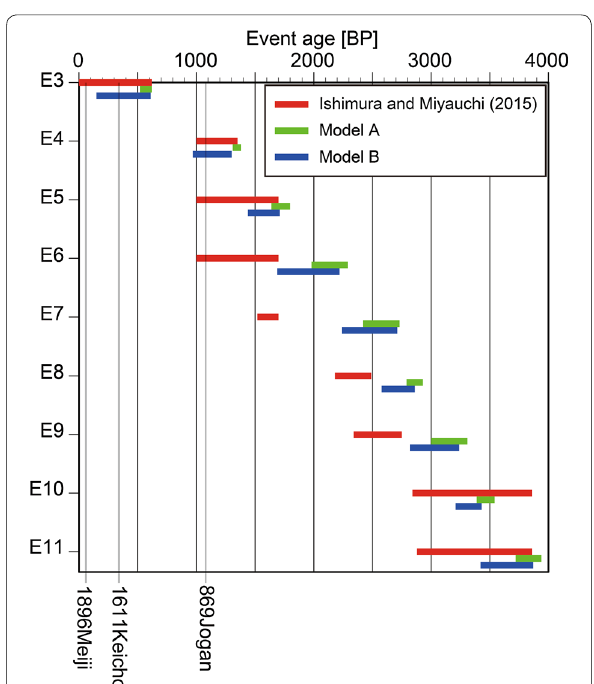
Fig. 5 Event age